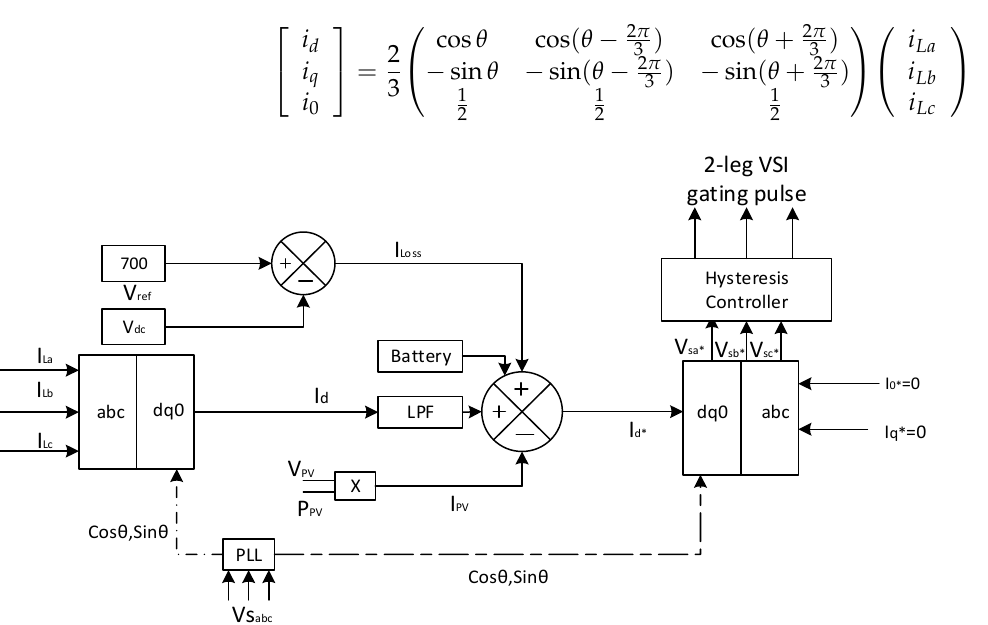
Figure 4. Conventional control strategy of PV-battery-shunt active power filter.